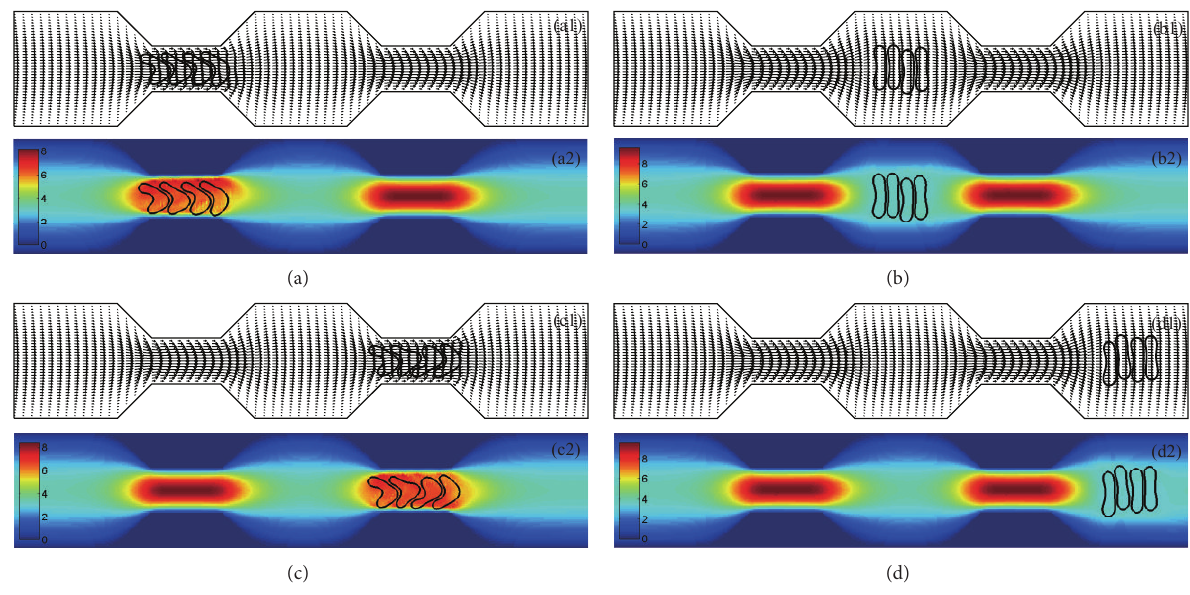
Figure 9: Motion and dissociation of a four-cell erythrocyte aggregate which is vertically placed in a 8 𝜇 m stenotic channel at time instants (a) 𝑡 = 0.48 ms; (b) 𝑡 = 0.91 ms; (c) 𝑡 = 1.32 ms; and (d) 𝑡 = 1.75 ms. Velocity vectors (a1-d1) and axial velocity magnitude contours (cm/s) (a2-d2) are presented. The initial configuration for the aggregate is shown in Figure 1(d), and the aggregate is vertically placed in the channel initially. The parameters used are 𝐷 𝑒 = 1.0 𝜇 J/m 2 , 𝑘 𝑏 = 5.0 × 10 −13 Nm.